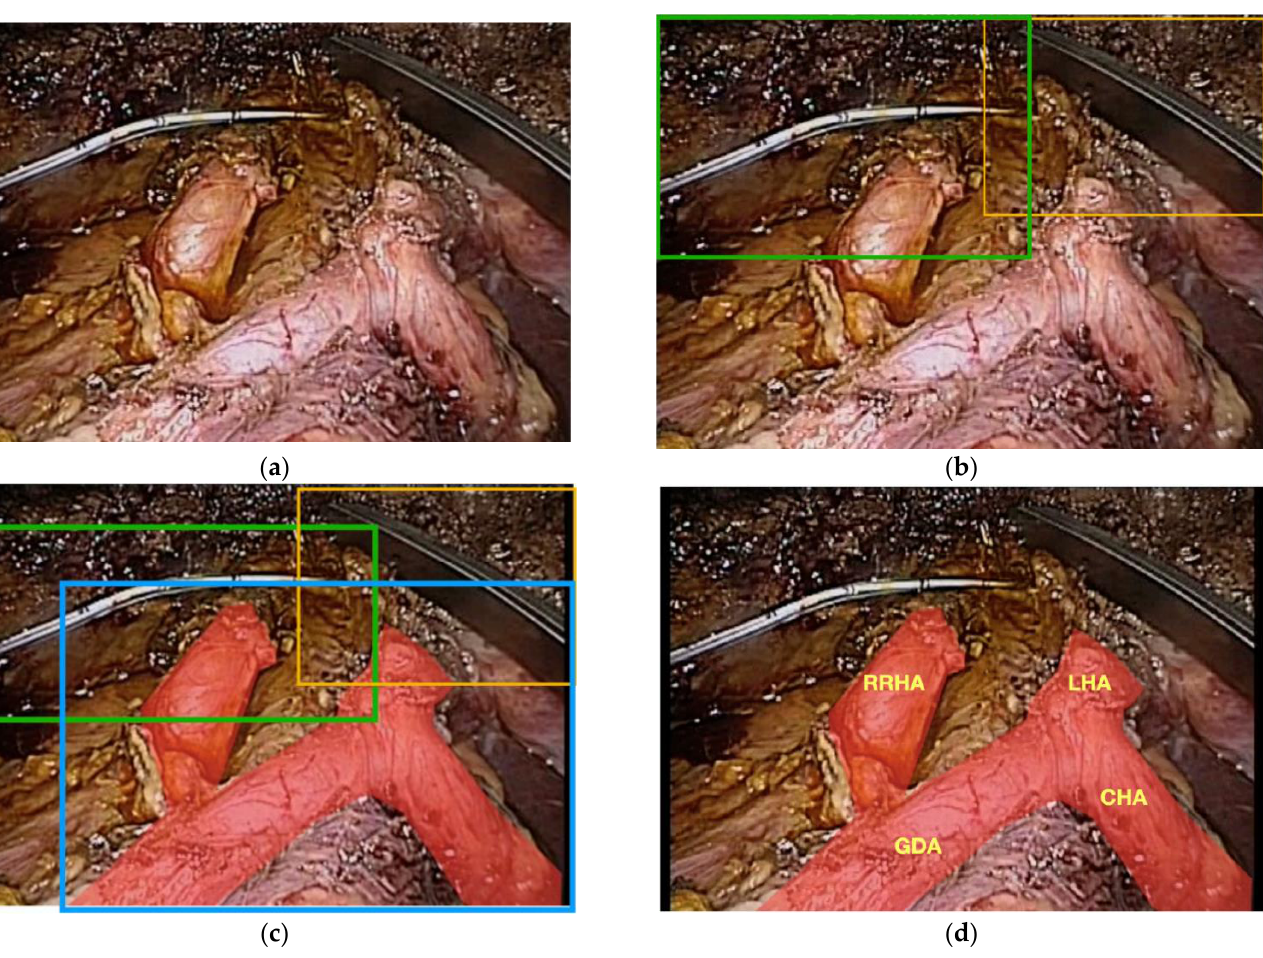
Figure 5. ( a ) Raw footage of the portal triad during a minimally invasive radical cholecystectomy and common bile duct excision for a patient with gallbladder cancer; ( b ) bounded boxes showing instance segmentation of the surgical instruments; ( c ) bounded boxes of instruments and entire arterial supply without multi-class segmentation of the different arteries; ( d ) patient has a replaced right hepatic artery that is not identified by lower-level segmentation.